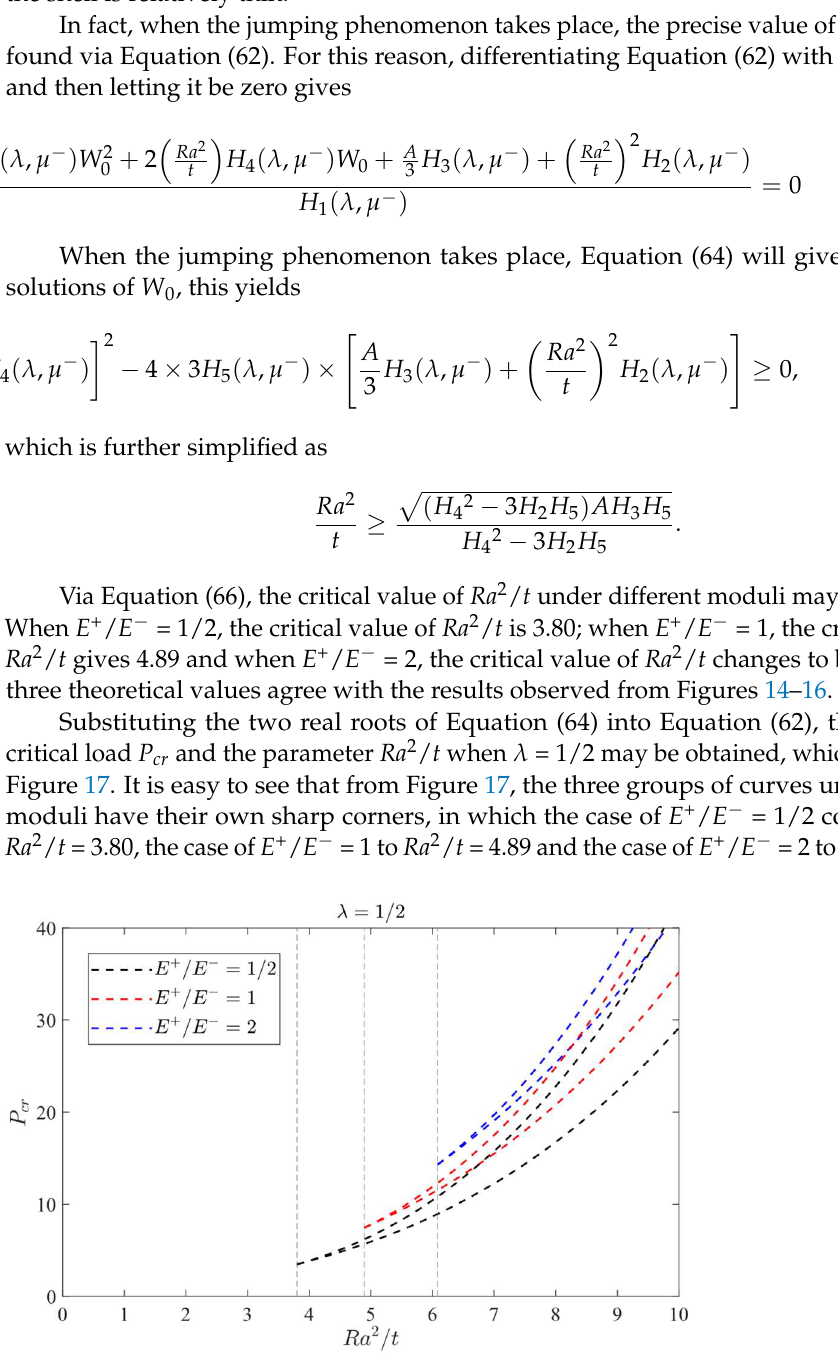
Figure 17. Variation of critical loads with Ra 2 / t values under different moduli ratios when λ = 1/2.